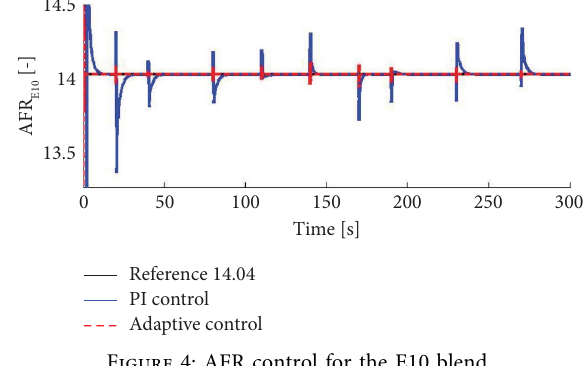
Figure 4: AFR control for the E10 blend.